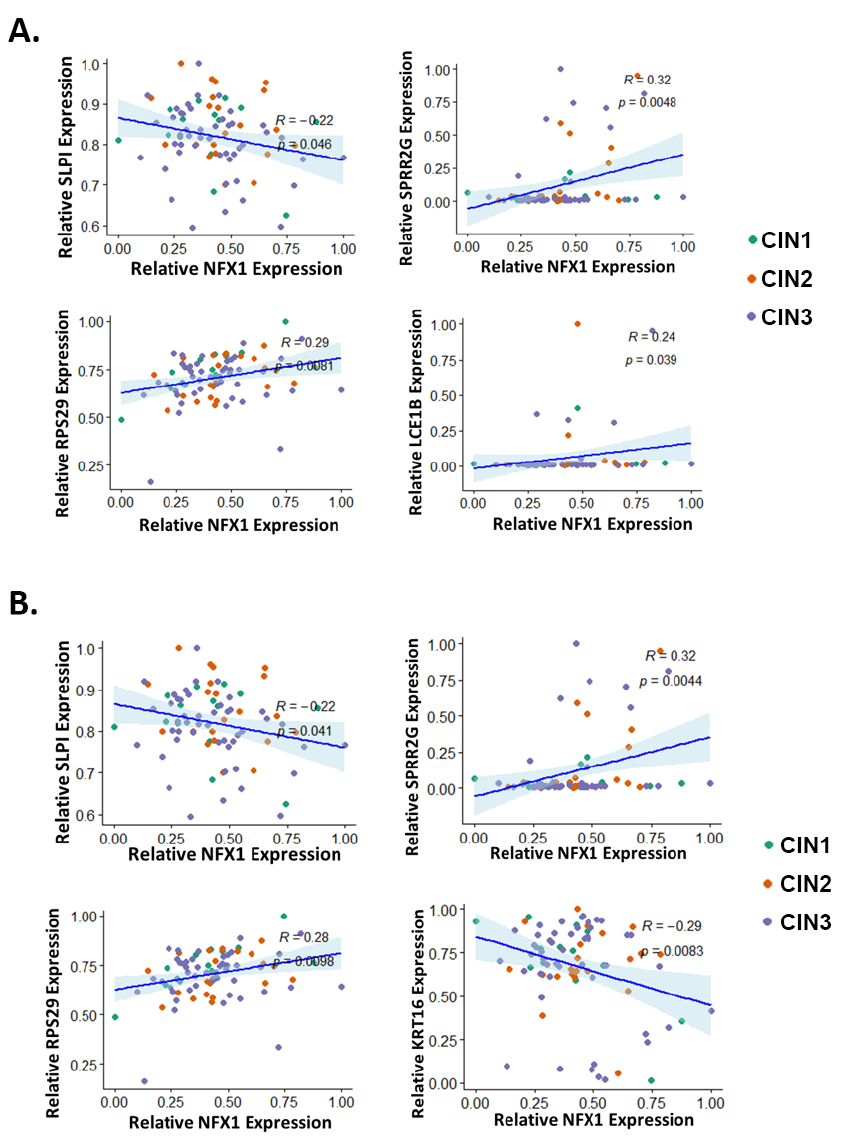
Figure 6. Correlation of LASSO-identified genes with NFX1 expression in premalignant cervical lesions. The expression of each LASSO-identified genes was plotted ( y -axis) against the expression of NFX1 ( x -axis) in premalignant cervical lesions. LASSO-identified genes whose expression has significantly correlated with NFX1 as determined by ( A ) Spearman correlation analysis or ( B ) Pearson correlation analysis is shown. For all, R and p -values are shown. CIN1 = cervical intraepithelial neoplasia grade 1 (green), CIN2 = cervical intraepithelial neoplasia grade 2 (orange), and CIN3 = cervical intraepithelial neoplasia grade 3 (purple).